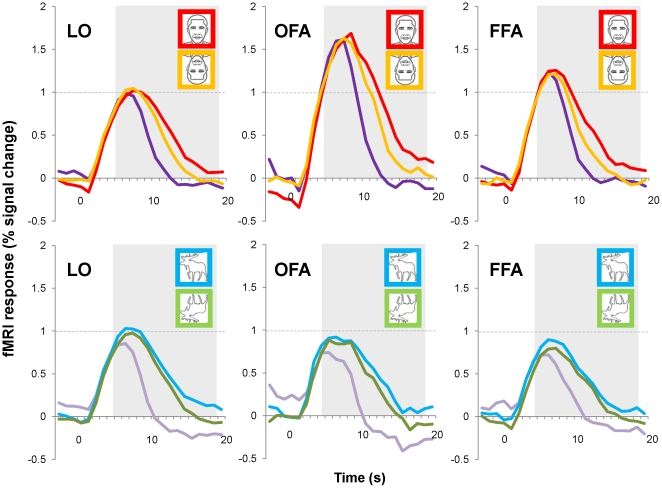
Average fMRI time courses.Event-related averages extracted from individually-defined ROIs. Red and orange time courses for faces are shown in the top row and correspond to upright faces and inverted faces in the Persist condition, respectively (purple = Vanishfaces). Blue and green time courses for animals are shown on the bottom row and correspond to upright animals and inverted animals in the Persist condition, respectively (purple = Vanishanimals). fMRI responses were highest to faces in the OFA and the FFA. fMRI activity in all three ROIs remained elevated for Persist conditions relative to Vanish conditions for both faces and animals. Additional elevation of fMRI activity was also apparent for upright stimuli, indicating a facilitation of persistence for upright faces and animals. The grey area indicates the time period over which our fMRI measure of persistence was computed.